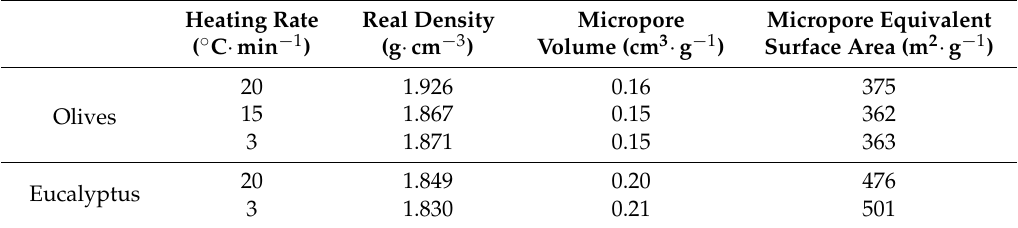
Table 7. Effect of heating rate in the textural characterization of the bioreducers (750 °C). Heating